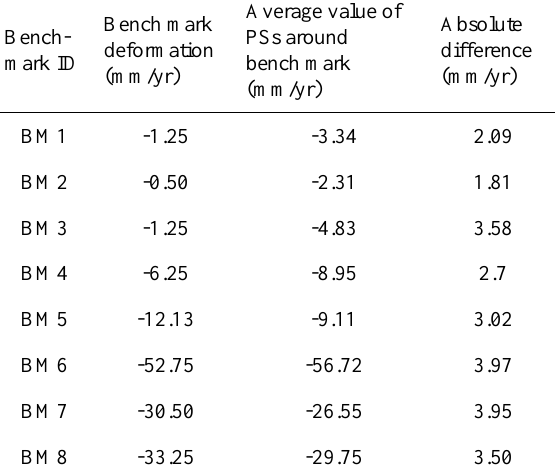
Table 3. The difference of land subsidence between benchmarks and